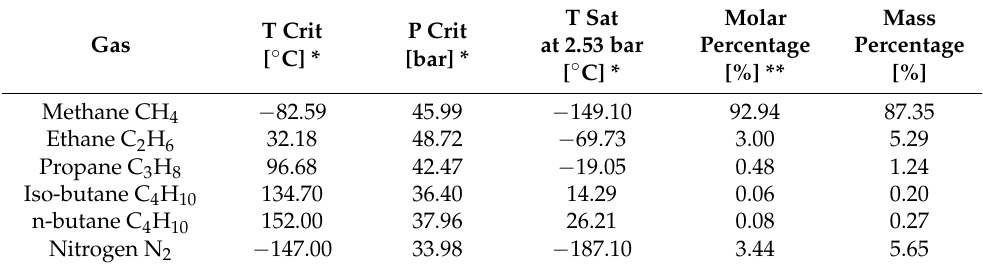
Table 1. Critical point and saturated temperature of some